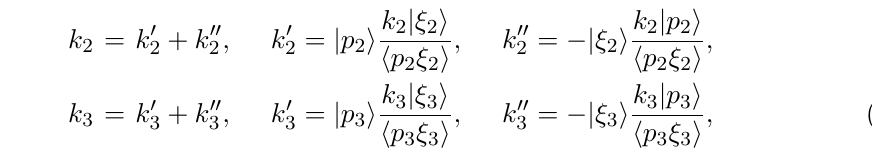
(1 + ; 2 (cid:3) ; 3 (cid:3) ) 1+2